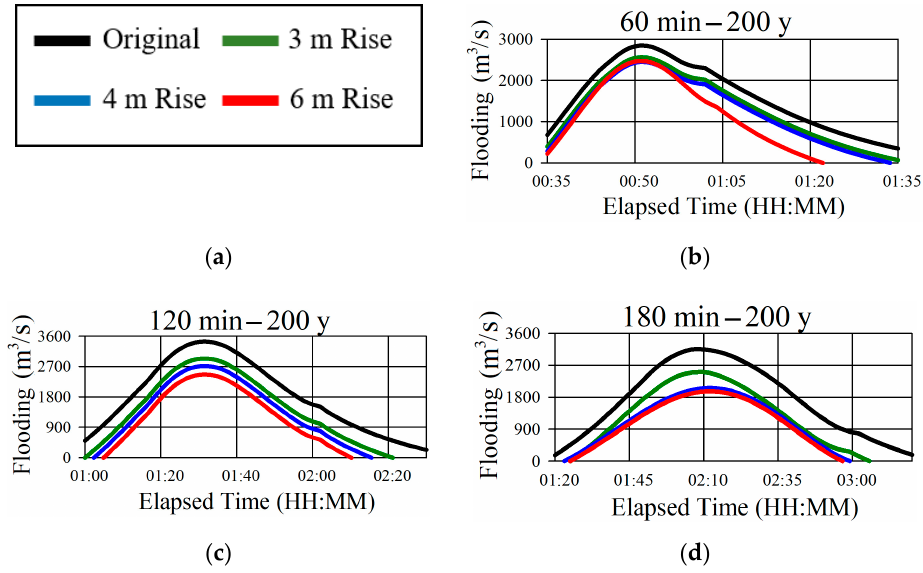
Figure 8. Flood reduction in the Suyeong River when the dam’s height is raised (rainfall